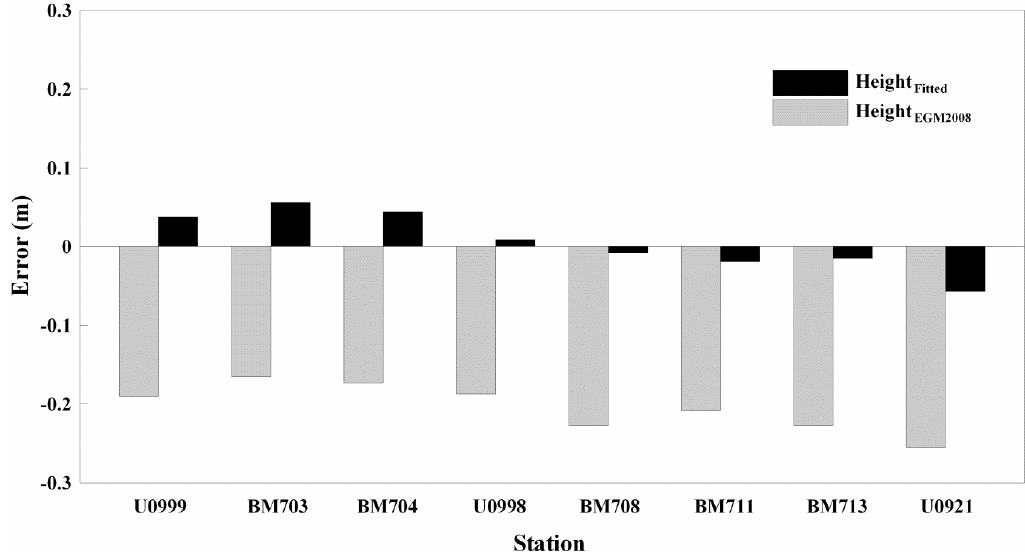
Figure 7. Height accuracy evaluation for Network RTK positioning using EGM2008 and EGM2008 applied to the Fitted